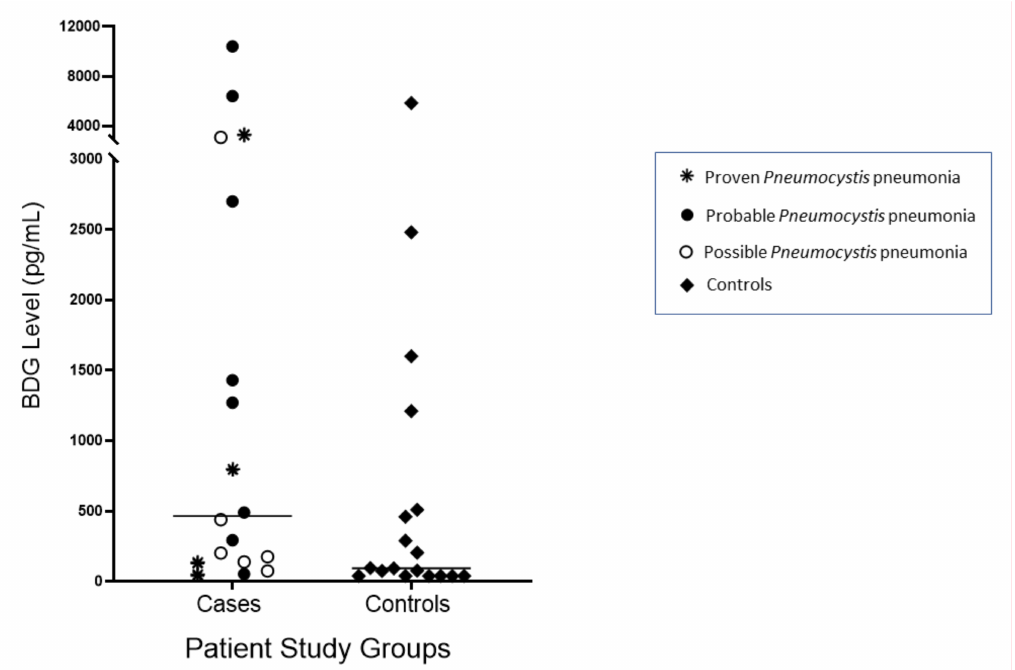
Figure 1. Bronchoalveolar lavage fluid (BALF) (1,3)- β - d -glucan (BDG) concentrations expressed as pg / mL in patients with Pneumocystis pneumonia characterized as proven, probable, and possible Pneumocystis infection (cases) and matched control patients. Bars represent the median BDG level for that